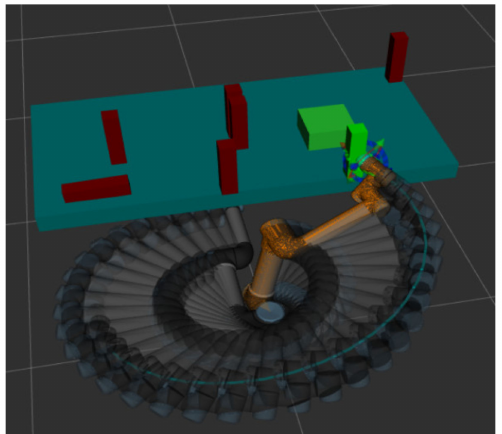
Figure 13. The trajectory diagram of the UR5 robotic